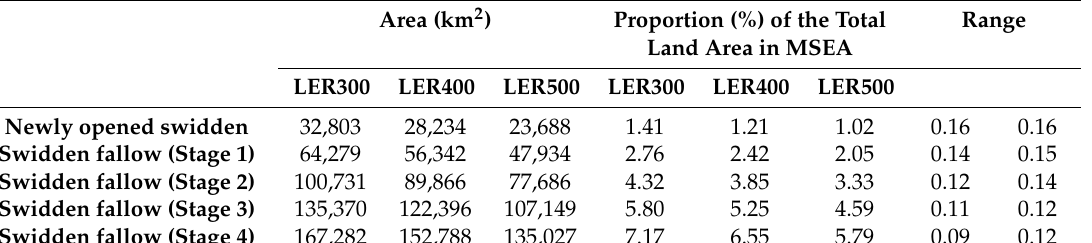
Table 3. Land area and its proportion of swidden agriculture landscape with the MST method in MMSEA.